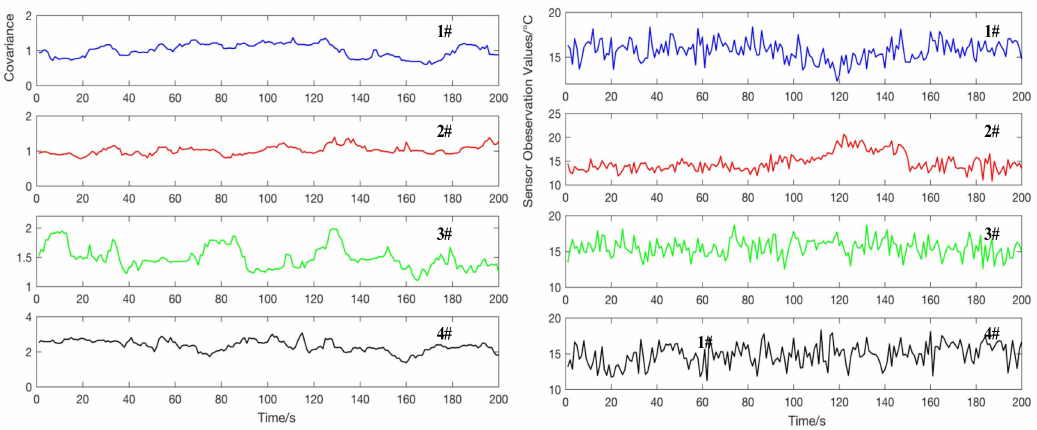
Figure 8. Estimation of noise variance based on wavelet transform for di ff erent